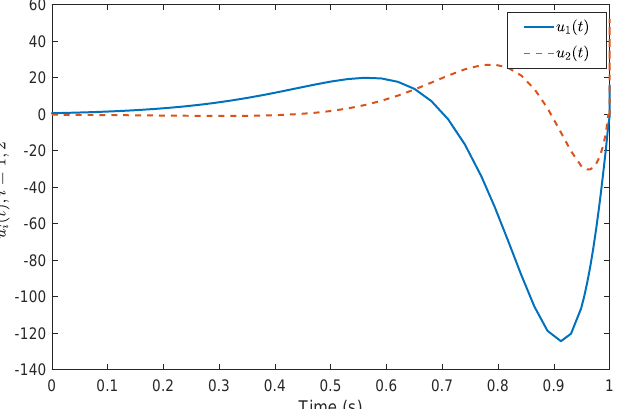
Figure 3. Control input u (t) by the prescribed-time controller.